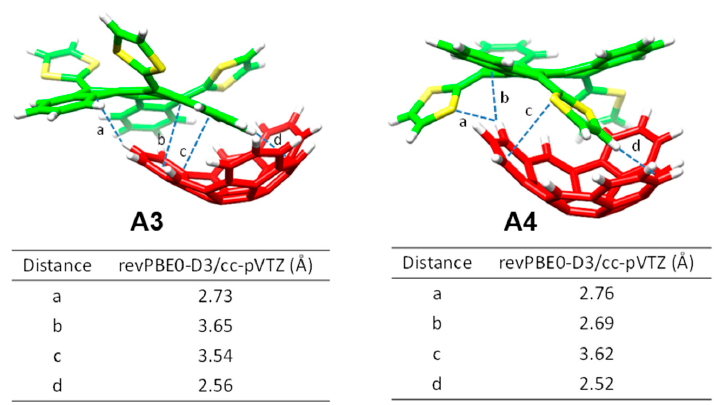
Figure 17. Selected intermolecular distances computed for structures A1 – A4 at the revPBE0-D3/cc-pVTZ level. For C 30 H 12 , the carbon and hydrogen atoms are depicted in red and white, respectively. For truxTTF, the sulfur, carbon and hydrogen atoms are colored in yellow, green and white, respectively. Adapted with permission from [18]. Copyright 2014 WILEY-VCH Verlag GmbH & Co. KGaA.